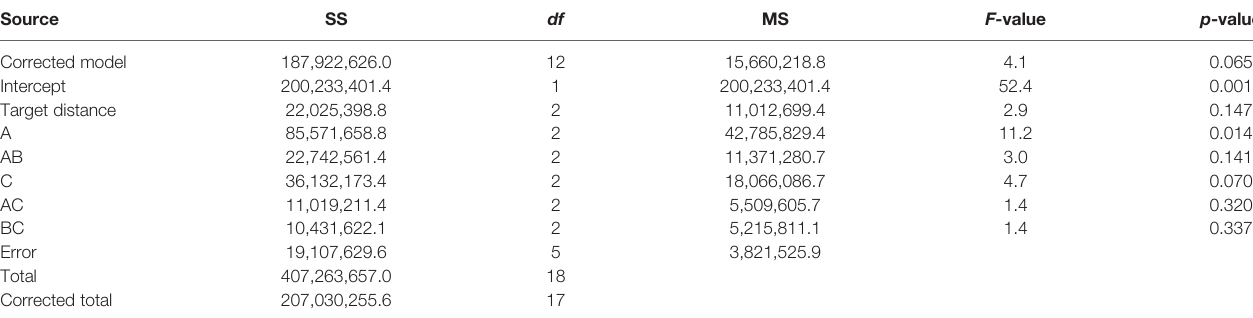
TABLE 2 | Variance analysis of orthogonal test.